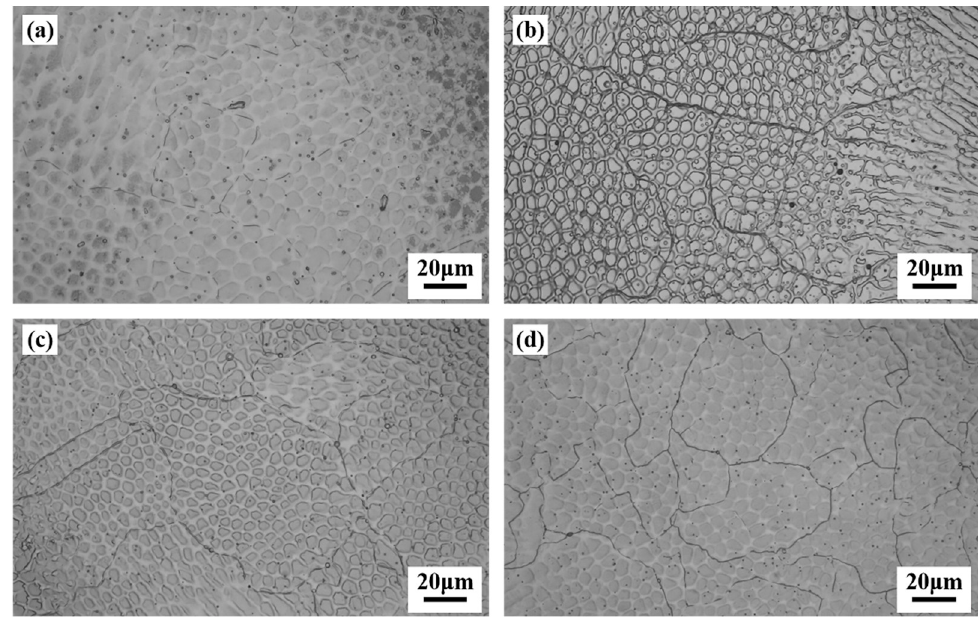
Figure 4. Microstructure of samples with different Mo contents in the deposited state: ( a ) Inconel 690; ( b ) 1.5 wt.% Mo; ( c ) 2.5 wt.% Mo; ( d ) 3.5 wt.% Mo. ( b ) 1.5 wt.% Mo; ( c ) 2.5 wt.% Mo; ( d ) 3.5 wt.% Mo.